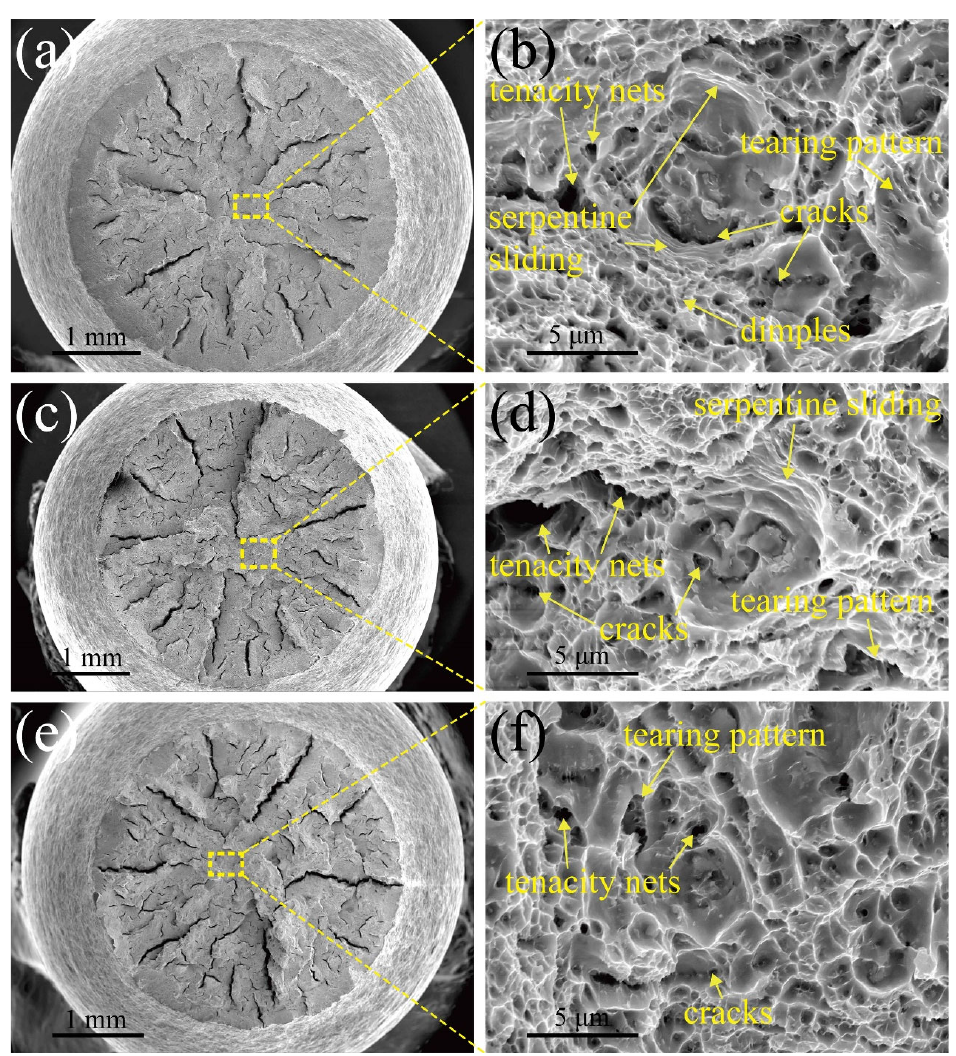
Figure 5. Fracture morphologies of tensile samples at RT: ( a , b ) 5 × 10 − 3 s − 1 ; ( c , d ) 5 × 10 − 4 s − 1 ; ( e , f ) 5 × 10 − 5 s − 1 .